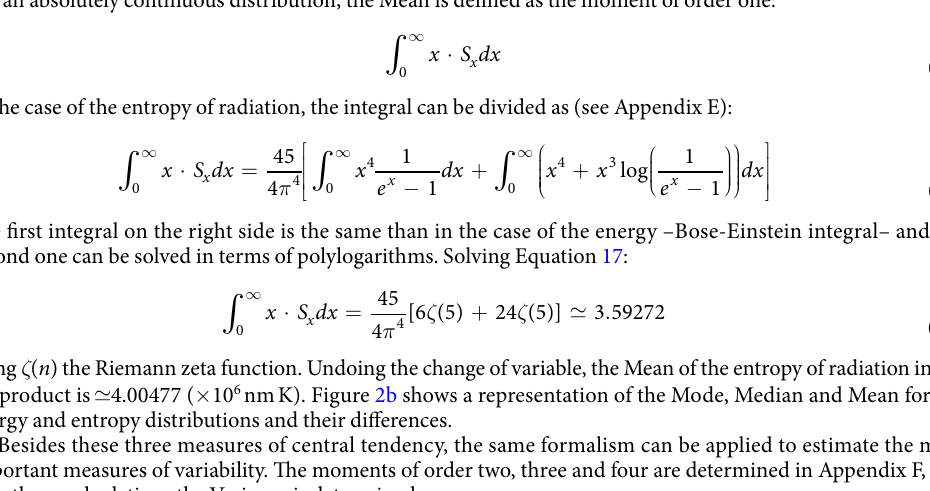
The solution of the previous equation is x med = 3.2536847. Undoing the change of variable =